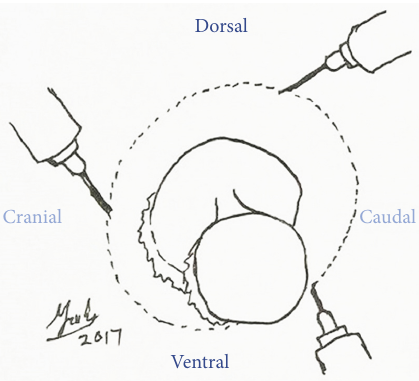
Figure 7: 2 Rochester Pean forceps were placed on the optic nerve, while ligation was done proximal to first forceps for haemostasis.